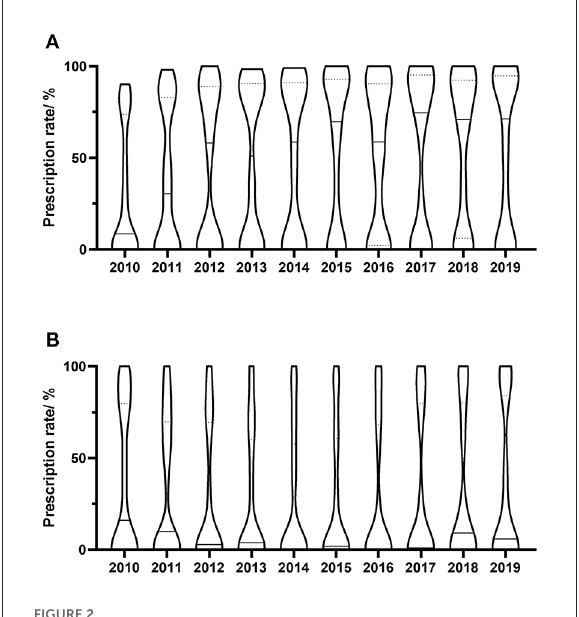
FIGURE2 Yearly distribution of antivirals prescriptions in individual hospitals. (A) Valaciclovir; (B) Famciclovir. Prescription rate means the yearly percentage of prescriptions containing specific drug. Each column shows the distribution of prescription rate of prescriptions containing specific drug, and the width of the column represents the relative number of hospitals. The dotted lines in column represent the first quartile and the third quartile of the distribution, and the solid line in column represents the median of the distribution.